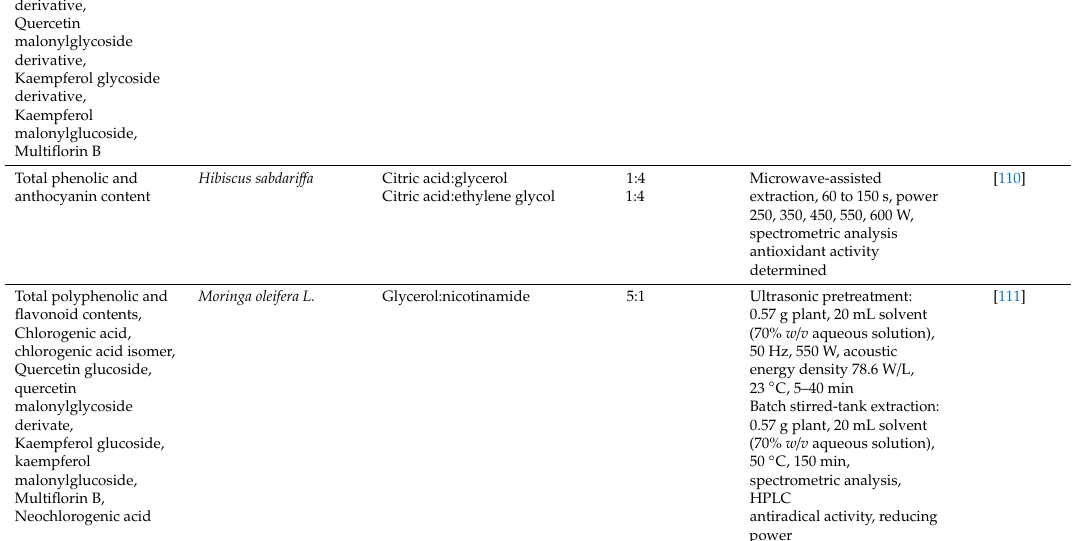
identity: Apigenin C-glycoside, Chlorogenic acid,